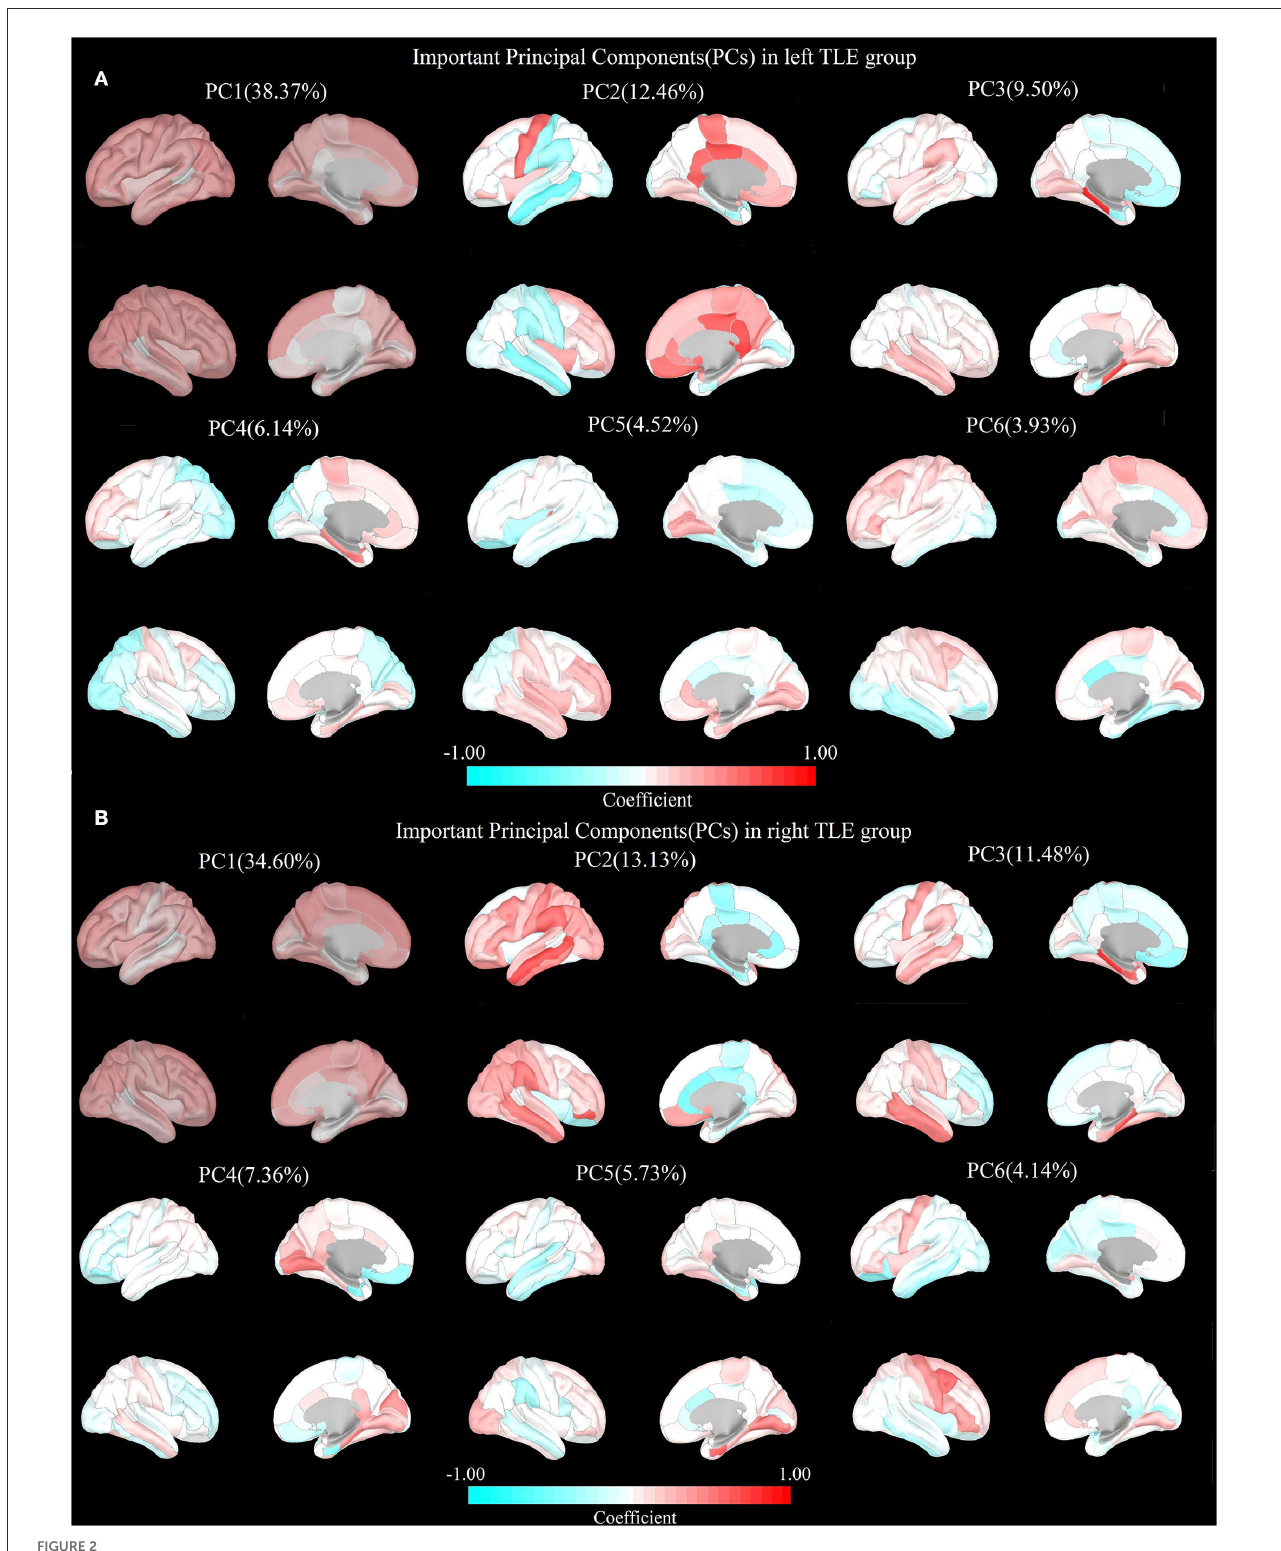
FIGURE2 Important principal components (PCs) in both TLEs. (A) Left TLE: PC1: Positive distribution in the extensive cortical regions. PC2: Negative distribution in the perisylvian regions. PC3: Negative distribution in the limbic regions. PC4: Negative distribution in the posterior cerebral regions. PC5: Negative distribution in the frontal, insula, cingulate gyrus, and parieto-occipital regions. PC6: Negative distribution in the bilateral temporal lobe. (B) Right TLE: PC1: Positive distribution in the extensive cortical regions. PC2: Negative distribution in the limbic regions. PC3: Negative distribution in the frontal, insula, cingulate gyrus, and parieto-occipital regions. PC4: Negative distribution in the bilateral temporal lobe. PC5: Negative distribution in the perisylvian regions. PC6: Negative distribution in the posterior cerebral